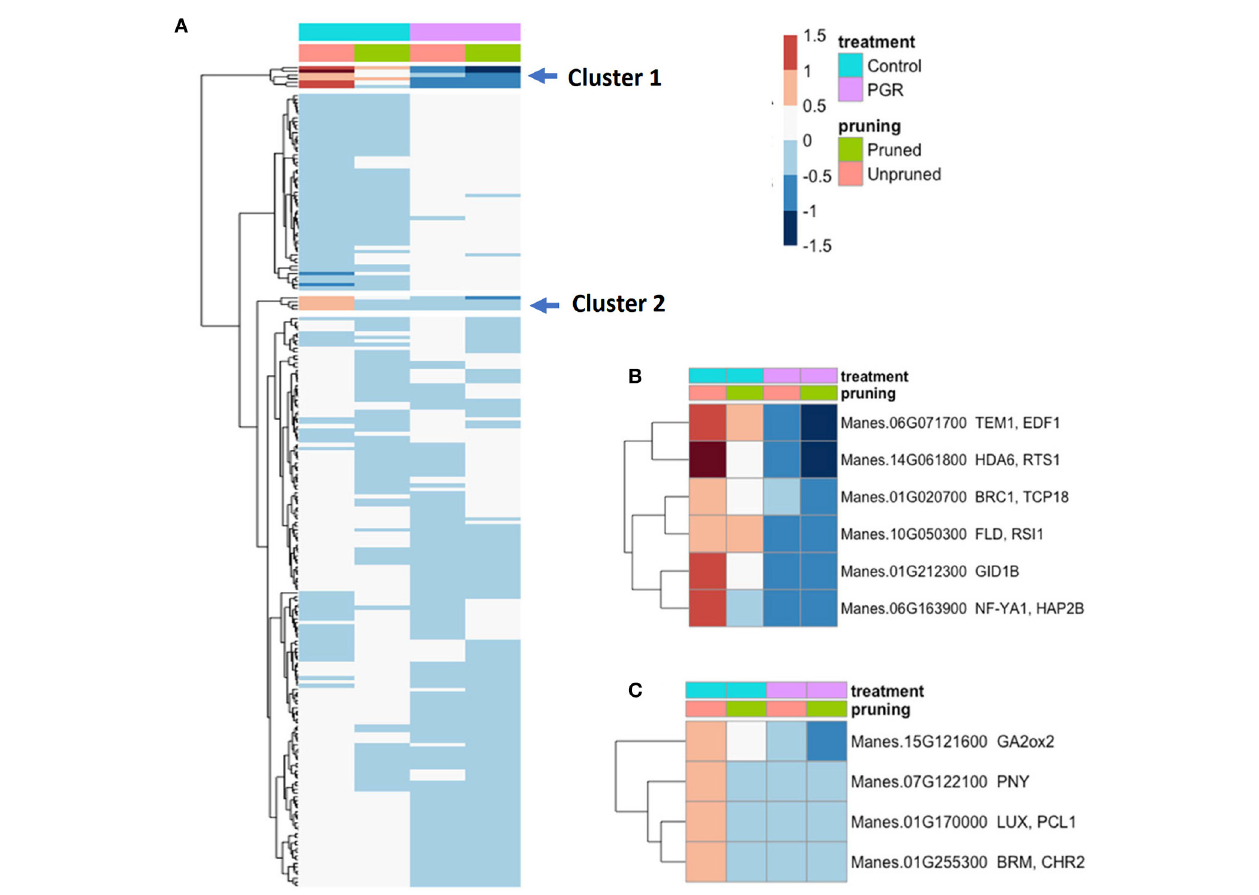
FIGURE 10 | (A) Expression of 217 differentially expressed flowering genes in response to PGRs and pruning. Clusters of highly affected genes are indicated with arrows. Clusters 1 and 2 are shown in detail in (B,C) , respectively. Averages of five biological replicates. Color scale indicates log 2 fold changes. Legend in header indicates color coding of variables. PGR, plant growth